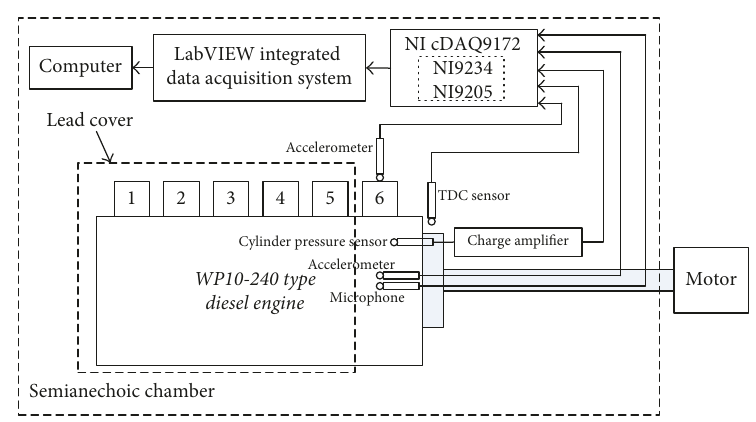
Figure 7: Vibration and noise measuring system of internal combustion engine.